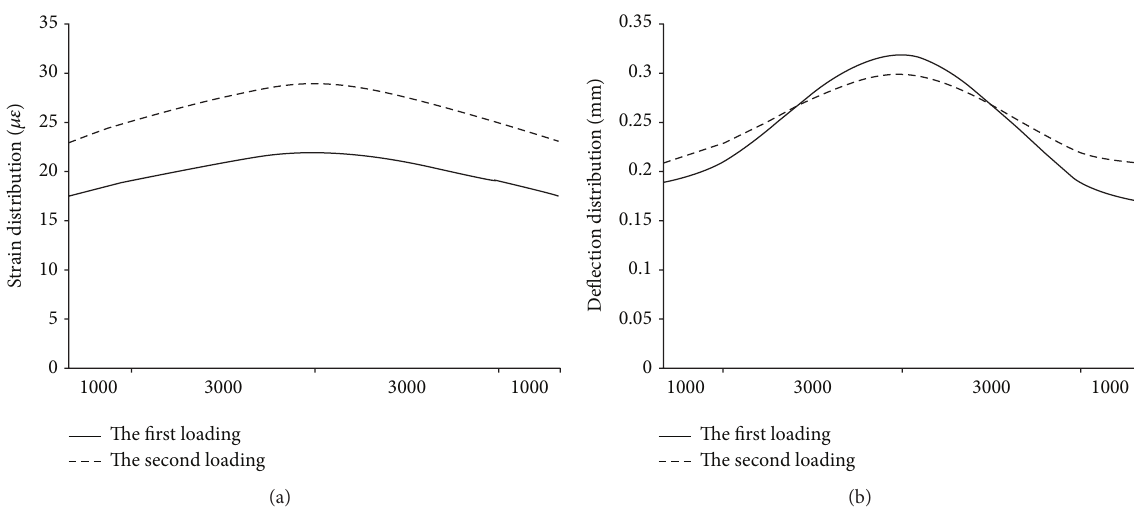
Figure 11: Deflection and strain distribution on the test cross section under the first condition: (a) strain distribution/ 𝜇𝜀 and (b) deflection distribution/mm.